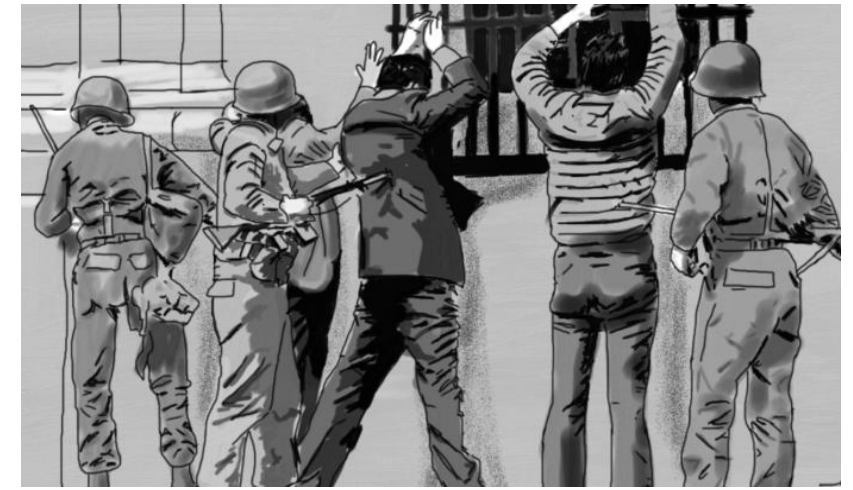
Figure 2. Frame from ¡ Viva Chile Mierda! (Goycoolea 2014). Picture courtesy of Adrian Goycoolea.